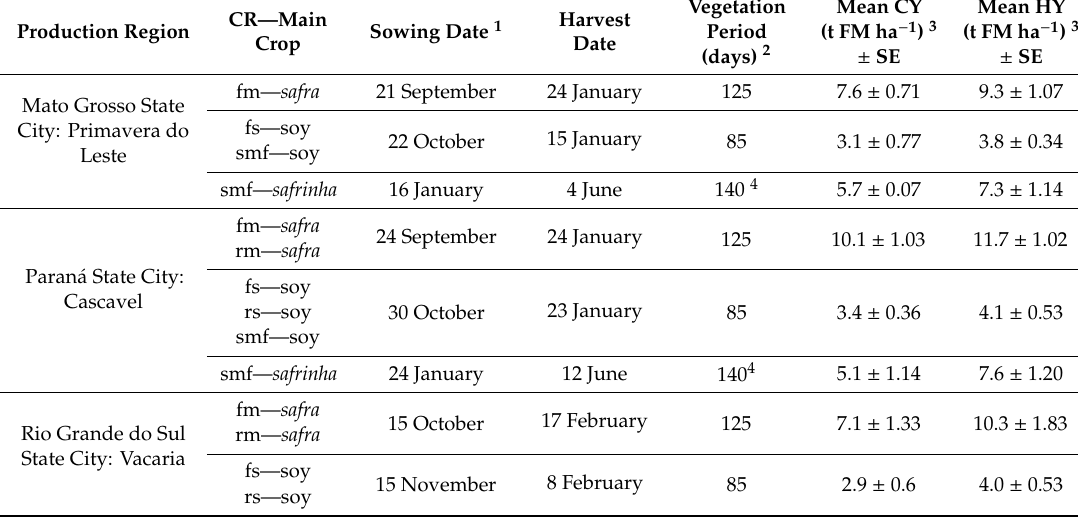
Table 2. Maize and soy produced on the sites analyzed and crop rotations from 2008 to 2018 (CR: crop rotation, CY: current annual mean of crop’s yield, HY: highest annual mean of crop’s yield, SE: standard